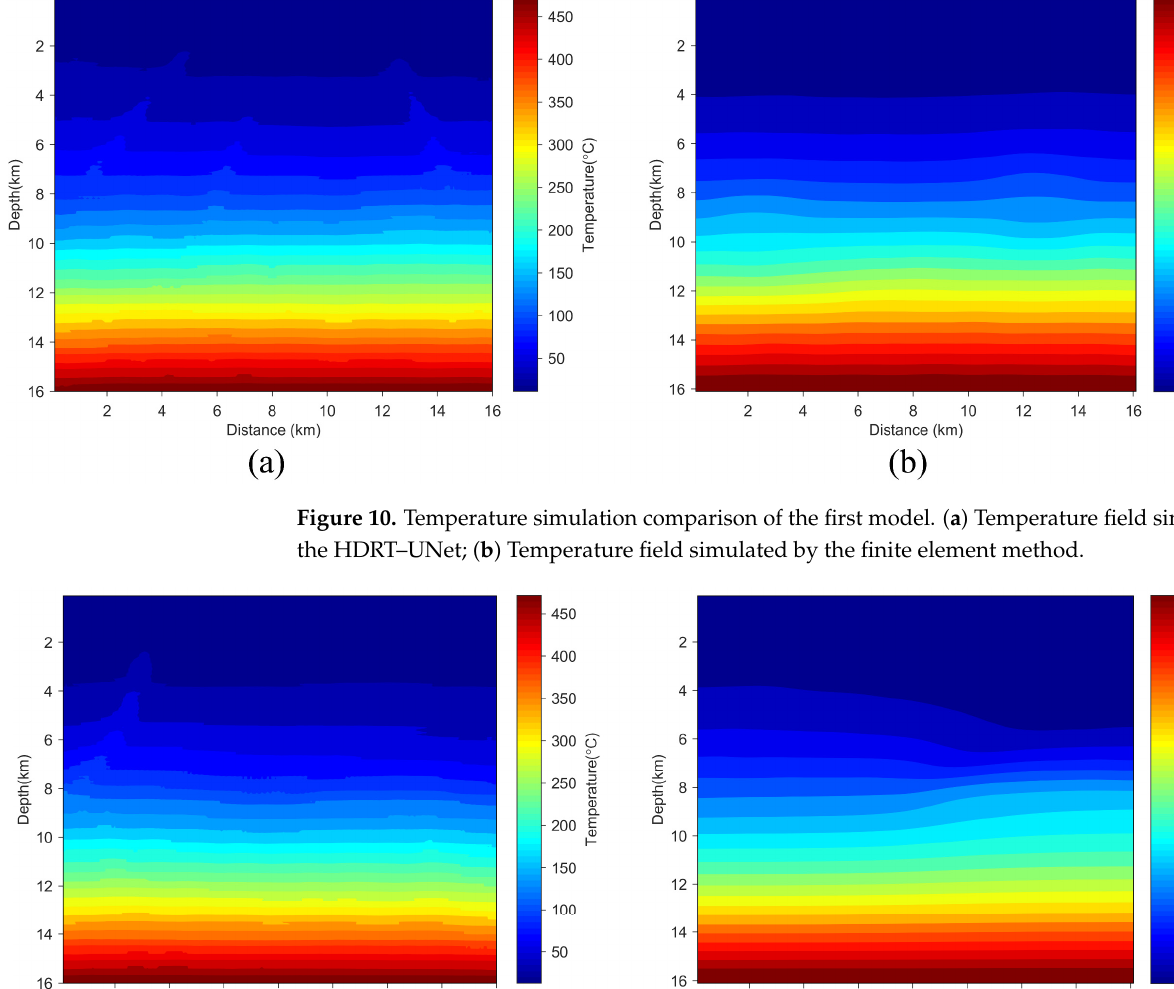
Figure 9. Two − dimensional (2D) geological model. ( a ) The first model consist of the heat conduction channels and granite with high thermal conductivity; ( b ) The second model contains fractures and caprock.